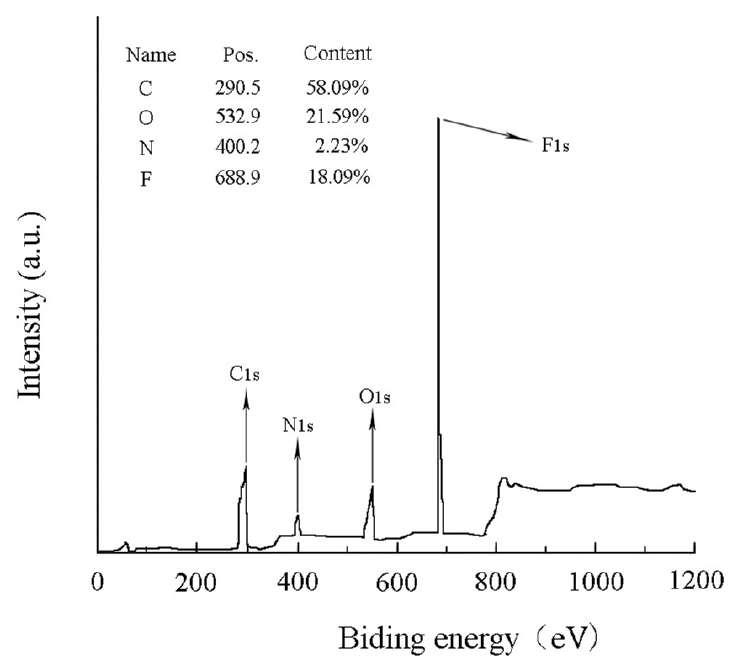
Figure 6. X-ray photoelectron spectroscopy (XPS) of fluoro coating polymer.